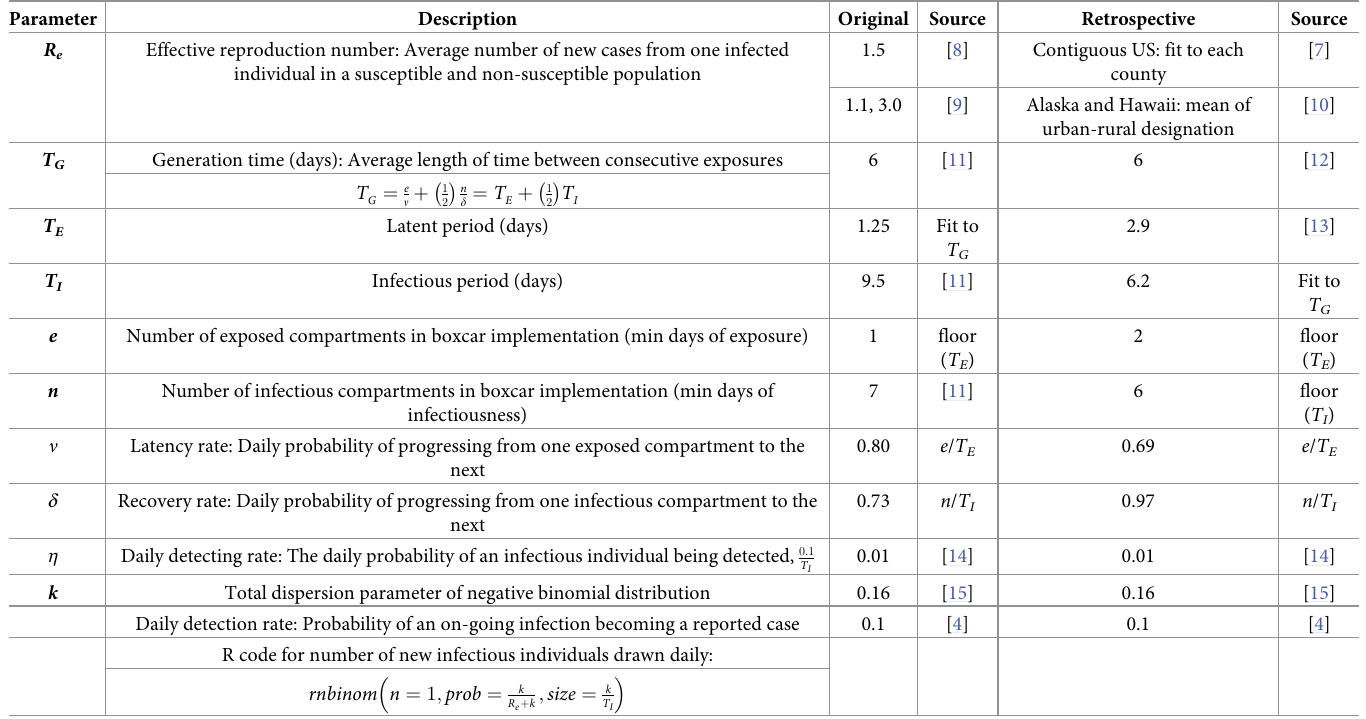
Table 1. Model parameters used for simulating COVID-19 outbreaks.